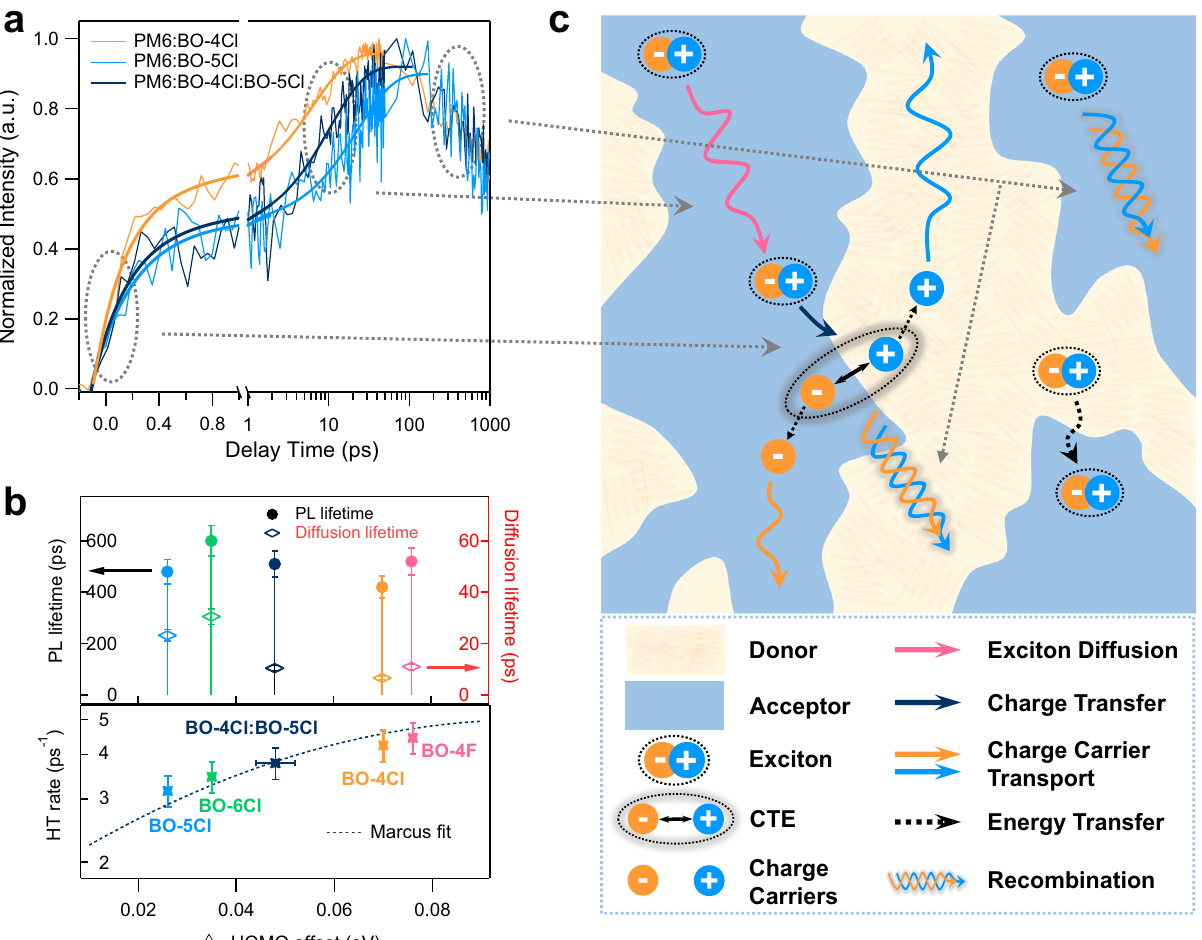
Fig. 3 Excited-state kinetics unveiled by transient absorption spectroscopy. a TA dynamic curves of the three blends. b Relation graph of PL lifetimes, diffusion lifetimes, hole transfer rates, and ionization potential ( “ HOMO ” ) offsets. The error bars are de fi ned as errors originated from the instrument and data fi tting. c Schematic of the behaviors of exciton and charge